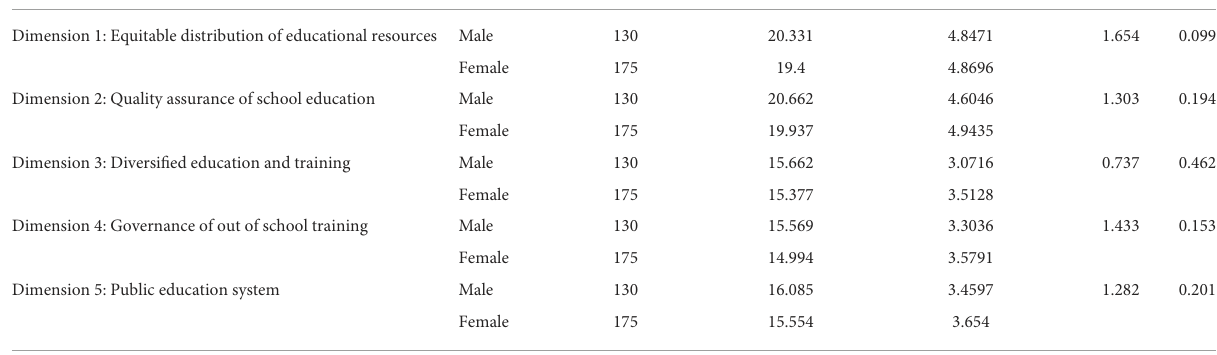
TABLE 9 Analysis of gender differences in data of various dimensions.